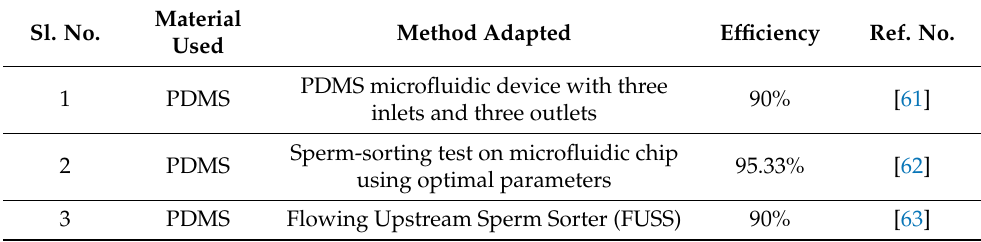
Table 2. Various oocyte sorting methods. Sl. No. Material Used Method Adapted Ref. No. PDMS, Glass substrate, Gold Electrode Glass substrate, ITO